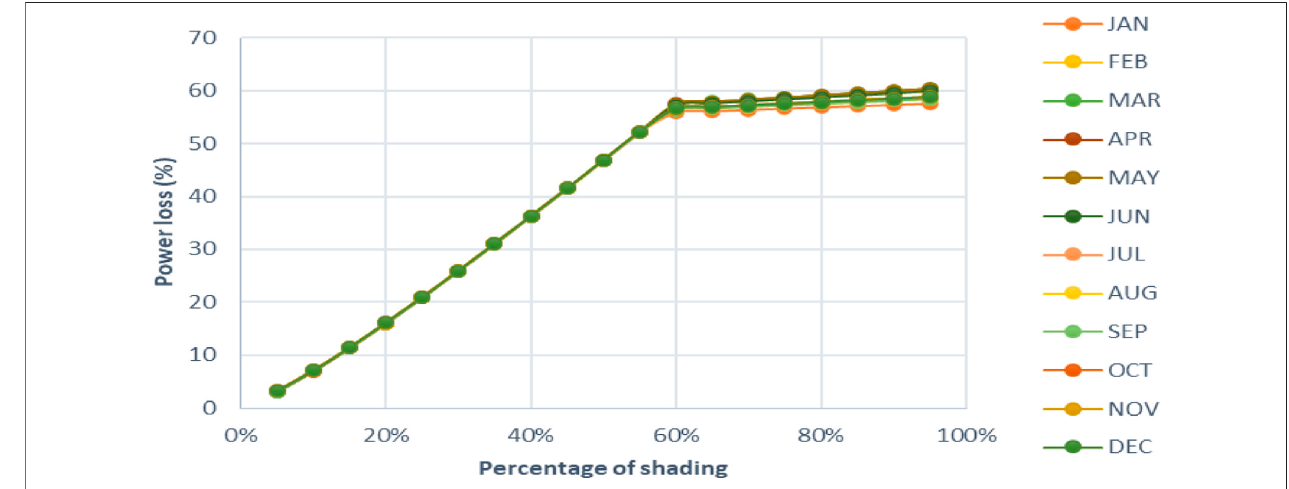
FIGURE 9 | Monthly power losses evolution.